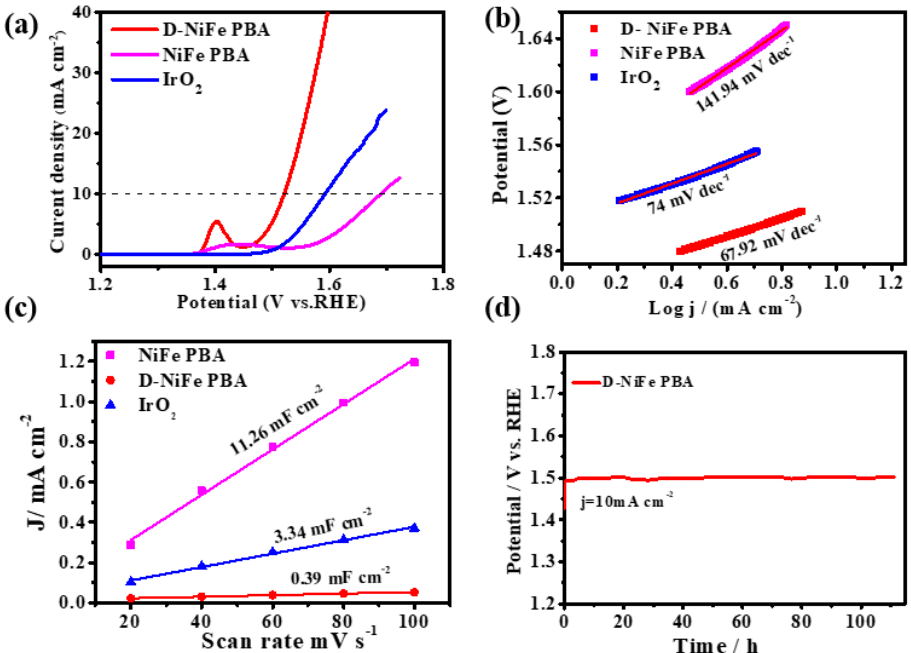
Figure 5. ( a ) LSV curves, ( b ) Tafel plot, ( c ) Cdl obtained from the data in CV curves recorded at different scanning rates for NiFe PBA, D-NiFe PBA and IrO 2 , ( d ) Current density as a function of scan rate for D-NiFe PBA.